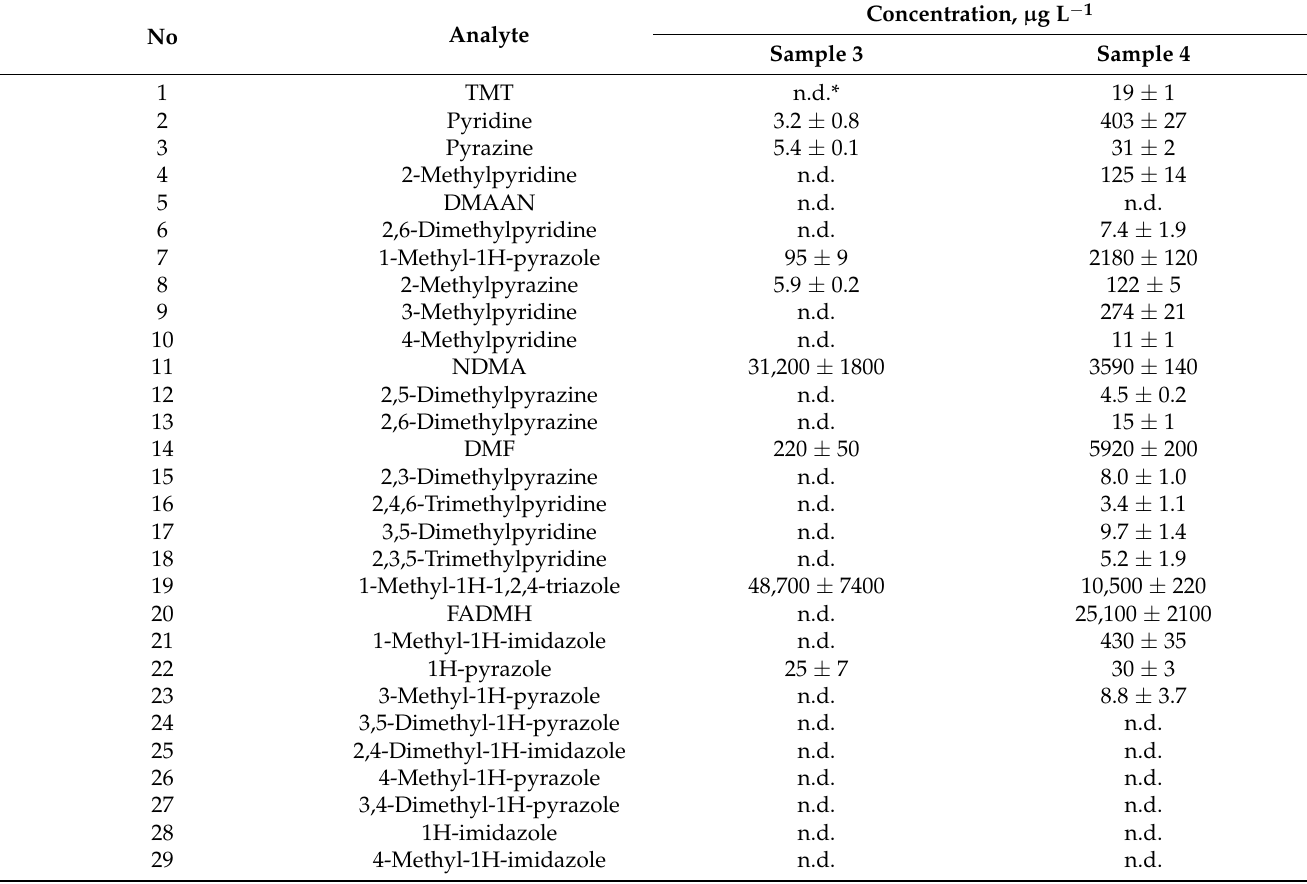
Table 3. Results of AWASP-GC-MS (MRM detection mode) analysis of real